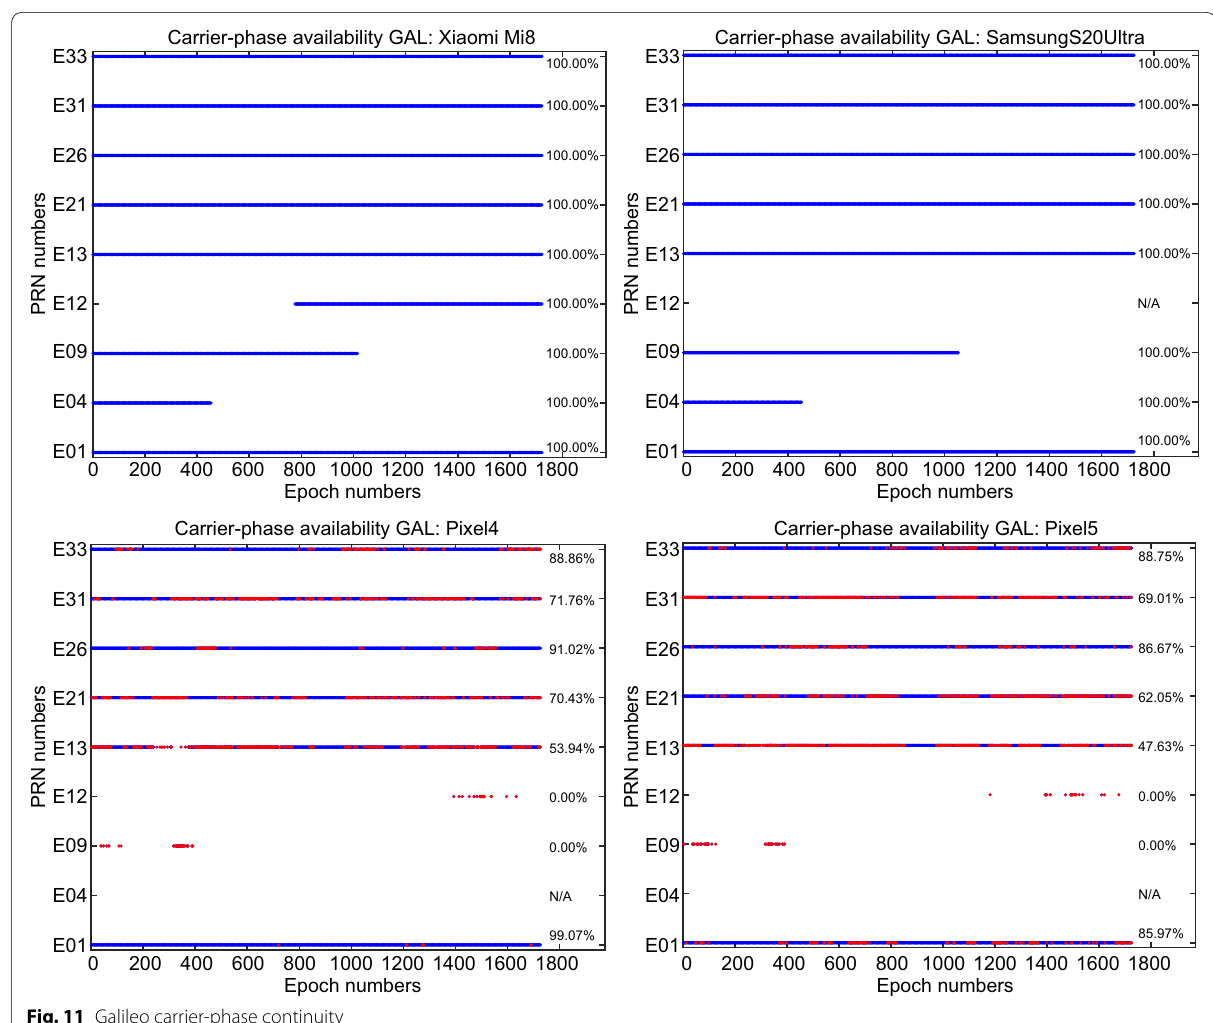
Fig. 11 Galileo carrier-phase